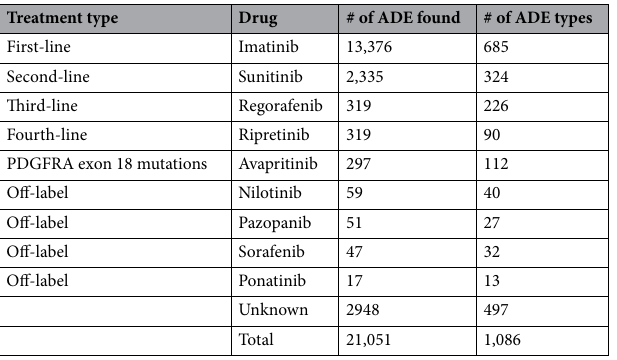
Table 1. The number of ADEs found for each medication type on the GIST patient